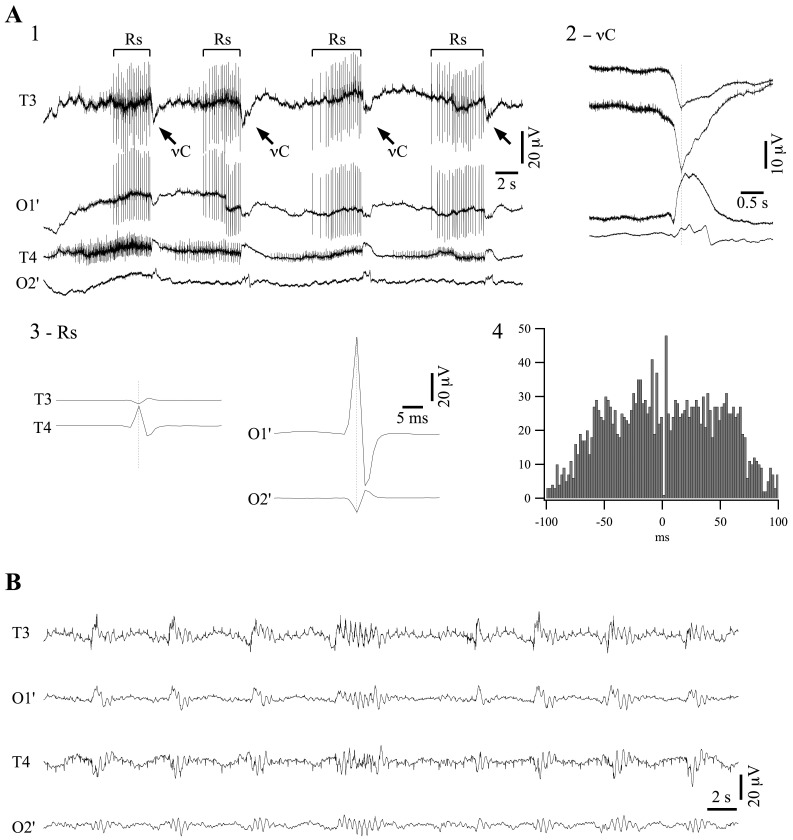
EEG recording of a patient in deep coma.(A1) Typical pattern of EEG recorded from temporal (T3 and T4) and modified occipital (O1′ and O2′) derivations. The pattern is dominated by ripples (Rs; bracket lines) and ν-complexes (νCs; oblique arrows). The recording also contains cardiac contamination, as often in comatose patients. (A2) Averaged νCs (n = 350). The negative peak of νCs in the O1′ derivation was detected and sweeps of 4 s around that time marker were extracted from each derivation and averaged. (A3) Averaged ripples (n = 5000). Left panel: Positive peak detection of Rs in the T4 derivation and averaging of all signals reveals no potentials in the occipital leads (not shown) and a reverted, less ample, ripple in T3. Right panel: similarly, positive peak detection in the O1′ derivation and averaging of all signals shows only a small and reverted ripple in O2′. (A4) Cross-correlogram between ripples in T4 and O1′ shows no time relationship. (B) Same patient, after removing antiepileptic drugs (carbamazepine, diazepam and thiopental) displays a pattern of burst-suppression. Here again, contamination of the EEG by the electrocardiogram, visible especially in the temporal leads. In this and following figures, all potentials are depicted with positivity upwards.